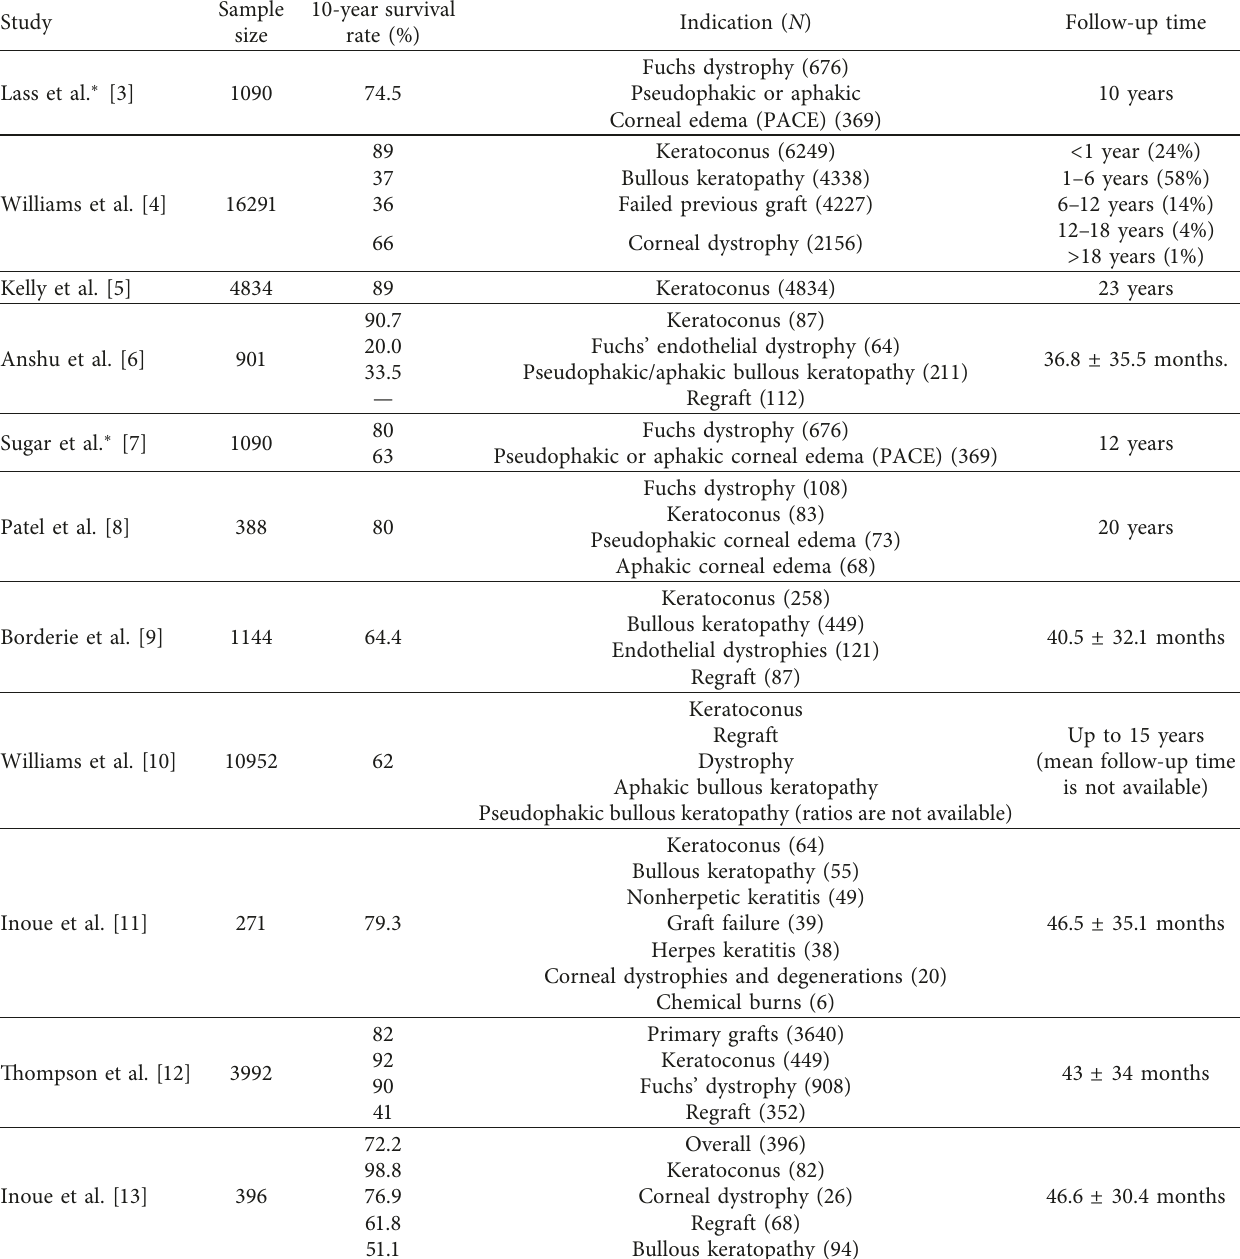
Table 1: Studies on 10-year graft survival of